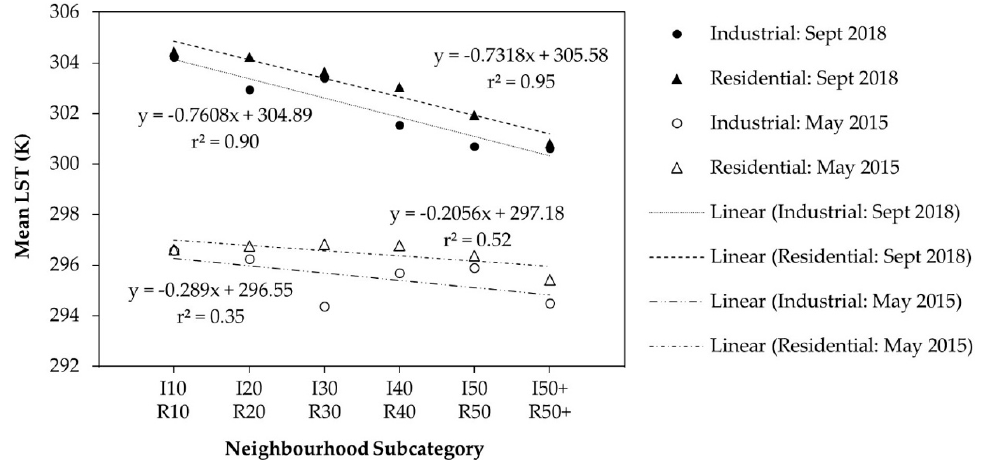
Figure 5. A scatterplot of the mean LST values comparing the two subcategory sets of industrial and residential neighbourhood categories for both 2018 (late summer) and 2015 (early spring), where each set consists with six subcategories. The linear regression coefficients of the both neighbourhood categories are representing the relations of mean surface temperature with the configuration of the subcategories of the neighbourhoods.